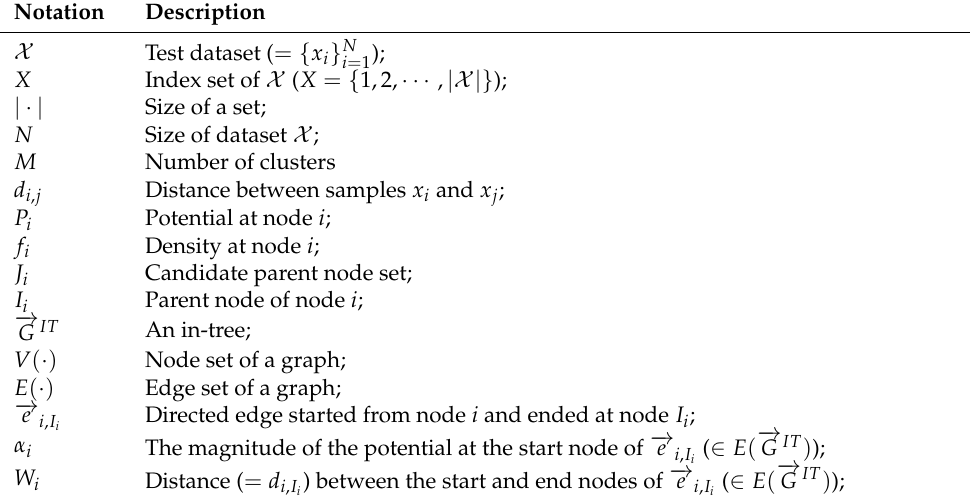
Table 1. Summary of the main